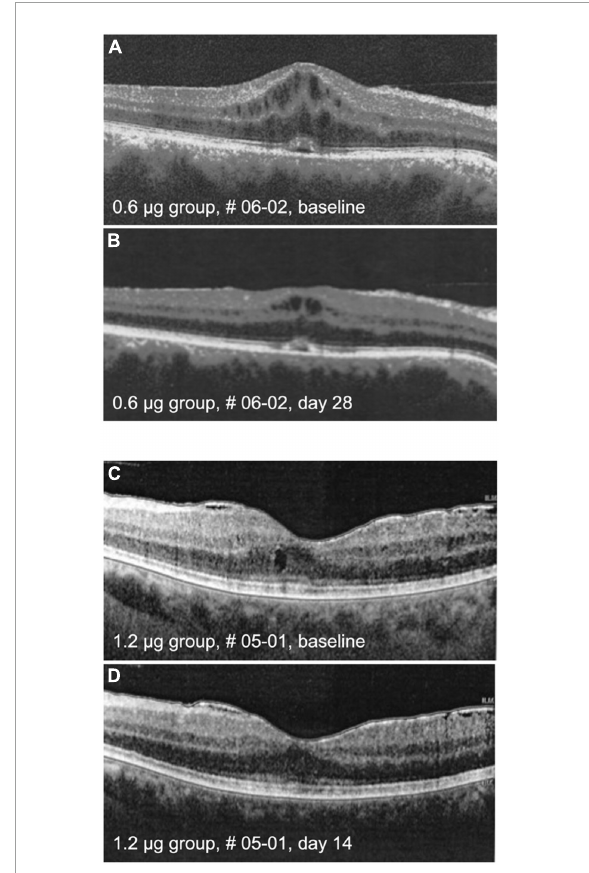
FIGURE6 Optical coherence tomography (OCT) images. The upper panel shows macula of patient # 06-02 at baseline (A) and on day 28 (B) after intraocular injection of 0.6 µ g KIO-100 (PP-001). Note a clinically meaningful reduction of cystoid macular edema (CME) in the region of the macula. In the lower panel the macula of patient # 05-01 is shown at baseline (C) and at day 14 (D) after injection of 1.2 µ g of KIO-100 (PP-001). In this case the initial size of CME spaces was much smaller, but after injection the CME has disappeared